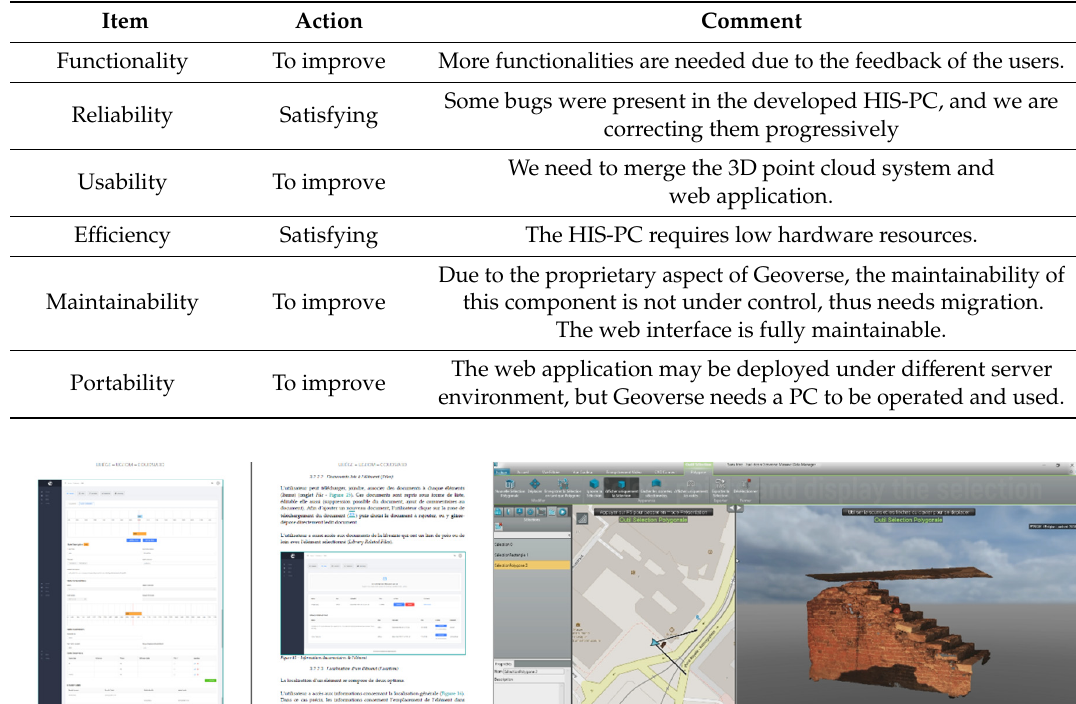
Table 2. Quality assessment of the HIS-PC prototype.